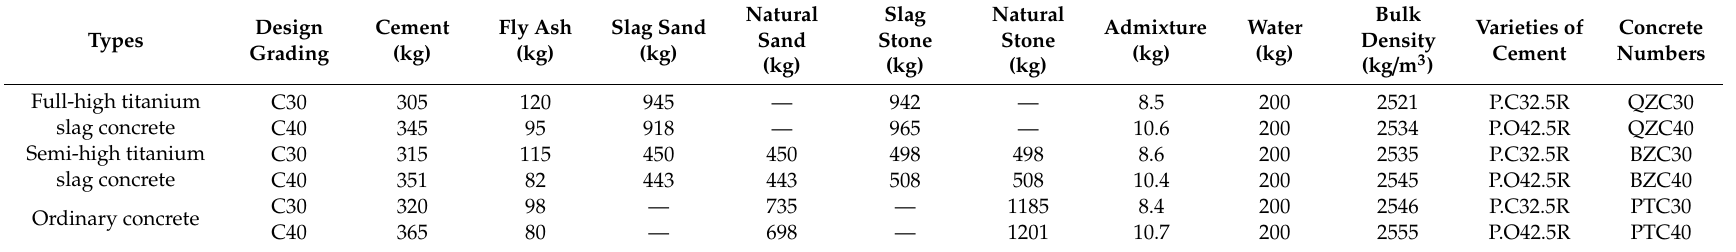
Table 3. Mix proportion of